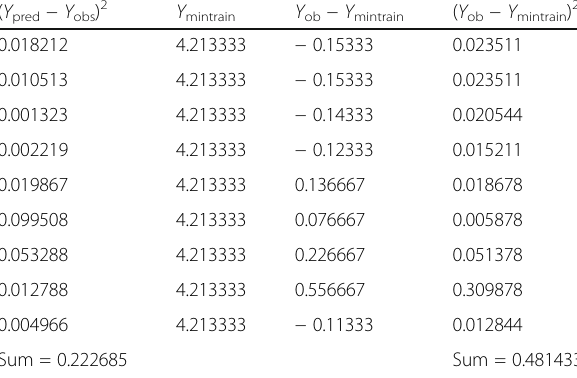
Table 4 Continuation of descriptor values of the test set used in external validation of model 4